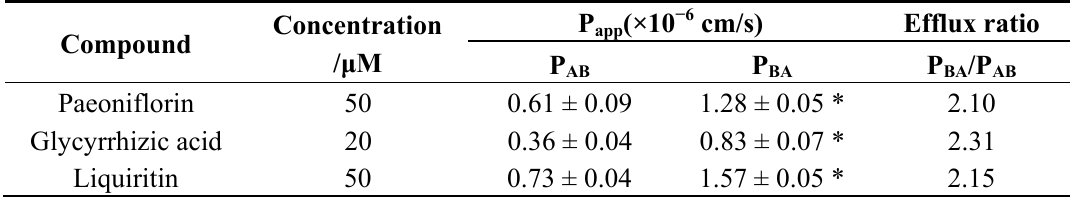
Table 1. Permeability of paeoniflorin, glycyrrhizic acid, and liquiritin.